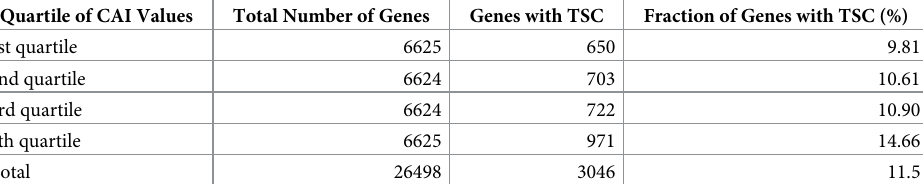
Table 3. Percent of Genes with TSC in each Quartile of T. Thermophila Genes Separated by CAI